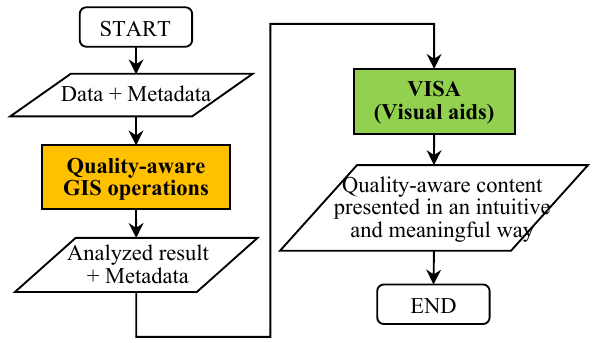
Figure 1. Flowchart of VISA-enabled